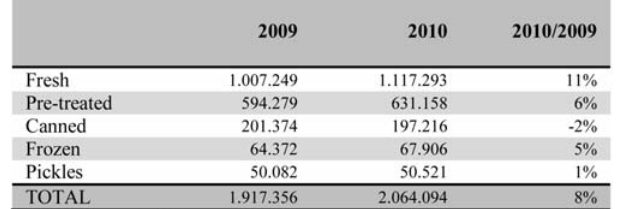
Table 6. Supermarket sales vegetables ( € x